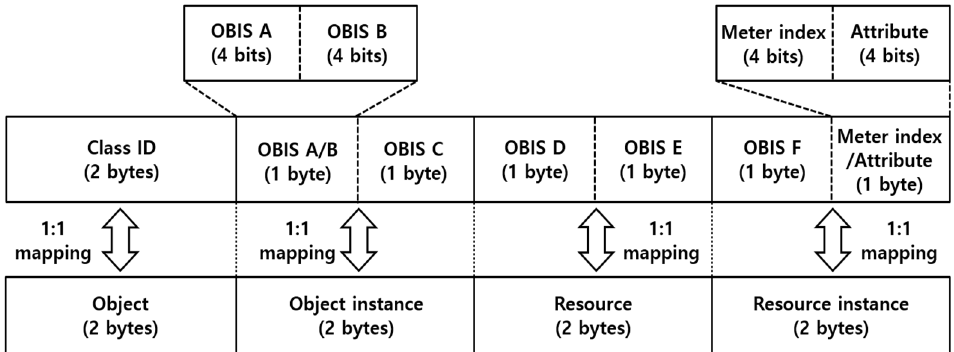
Figure 5. Resource conversion method between DLMS and LwM2M protocols.